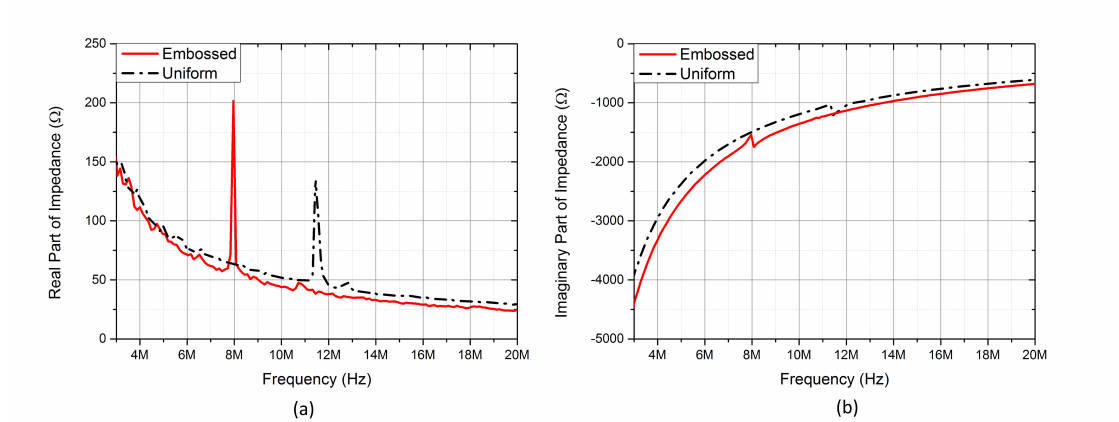
Figure 8. Electrical input impedance of the embossed and uniform CMUT cells bias at 150 V. ( a ) Real parts; ( b ) imaginary